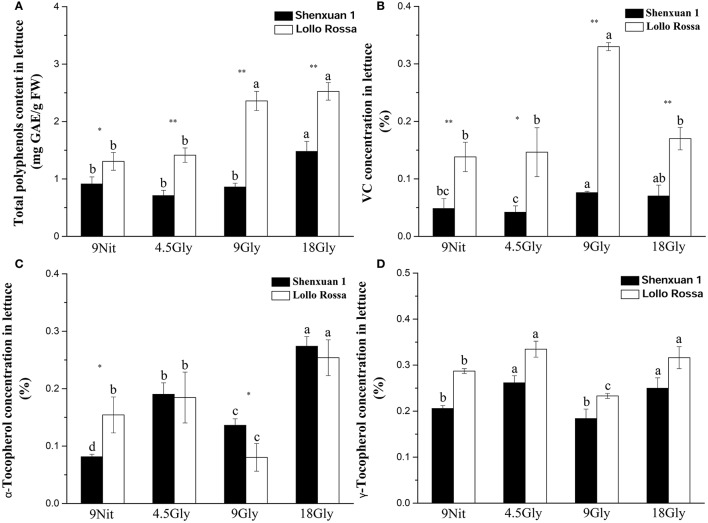
Effect of glycine and nitrate supply on the contents of bioactive compounds in lettuce leaf extracts. (A) Total polyphenol content; (B) ascorbic acid content; (C) α-tocopherol content; (D) γ-tocopherol content. Different small letters indicate significant differences, p < 0.05; LSD analysis (n = 3). The “*” (p < 0.05) and “**” (p < 0.01) indicate significance differences between cultivars (t-test).